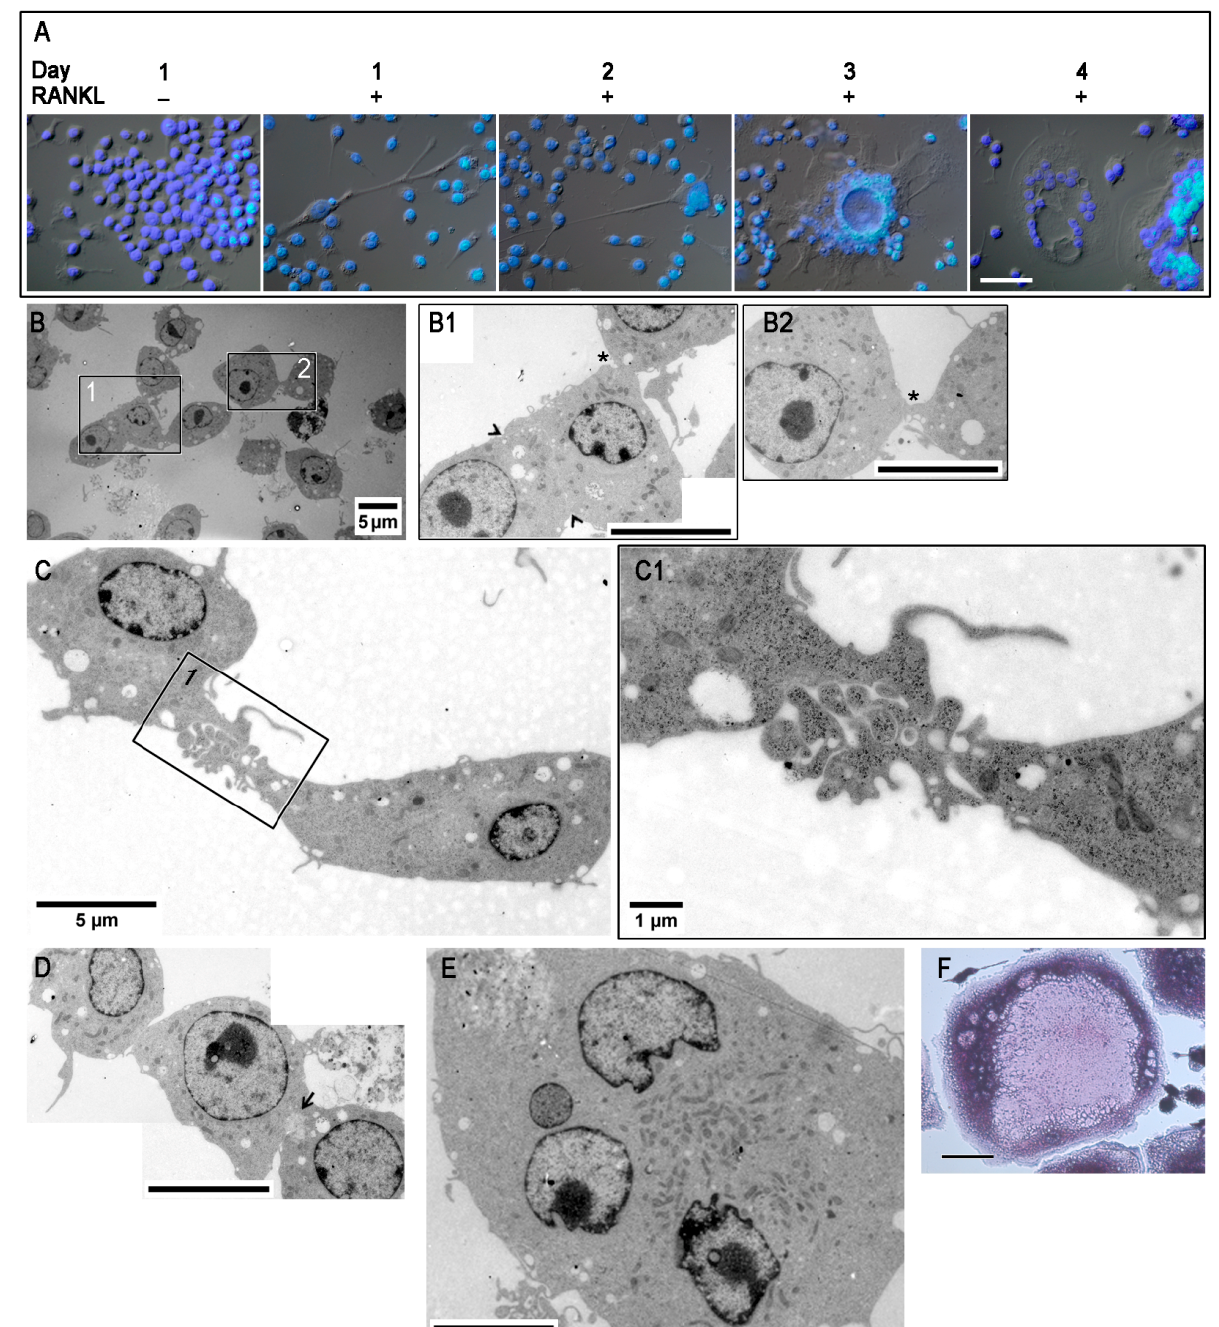
Figure 1. Timing of in vitro osteoclast differentiation. ( A ) Cells cultured in the absence, for 1 day (receptor activator of nuclear factor κ -B ligand (RANKL - ), or in the presence of RANKL (RANKL + ) for 1, 2, 3, and 4 days. Merge of brightfield and DAPI staining images, scale bar: 50 µm. ( B – E ) TEM images of 2 days RANKL + cells. ( B1 ) and ( B2 ), 3 × magnifications of framed areas in ( B ), showing recognition (*)/adhesion (arrowheads) between mononuclear cells; scale bars 5 µm. ( C1 ) 3.5 × magnification of framed area in ( C ), showing a large contact area between mononuclear cells. ( D ) Fusing cells through a “fusopode bridge” (arrow); scale bar 5 µm. ( E ) Large multinucleated cell; scale bar 5 µm. ( F ) TRAP staining of 4 days RANKL-stimulated cells. The data shown represent two independent experiments with comparable outcomes. Magnification 40×. Scale bar 50 µm.